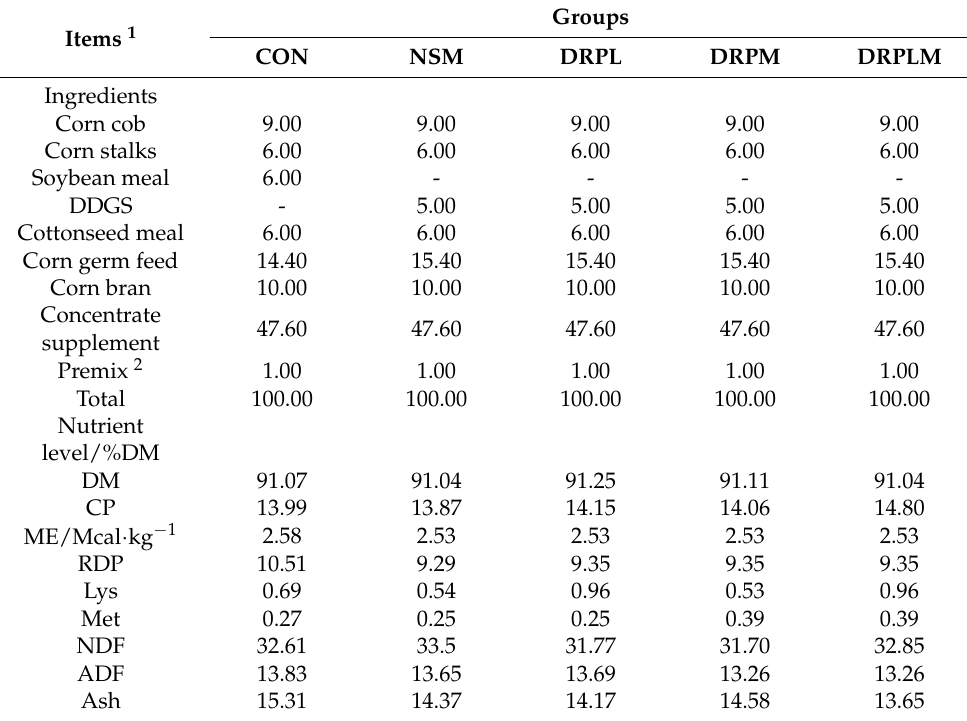
Table 1. Composition and nutrient levels of experimental